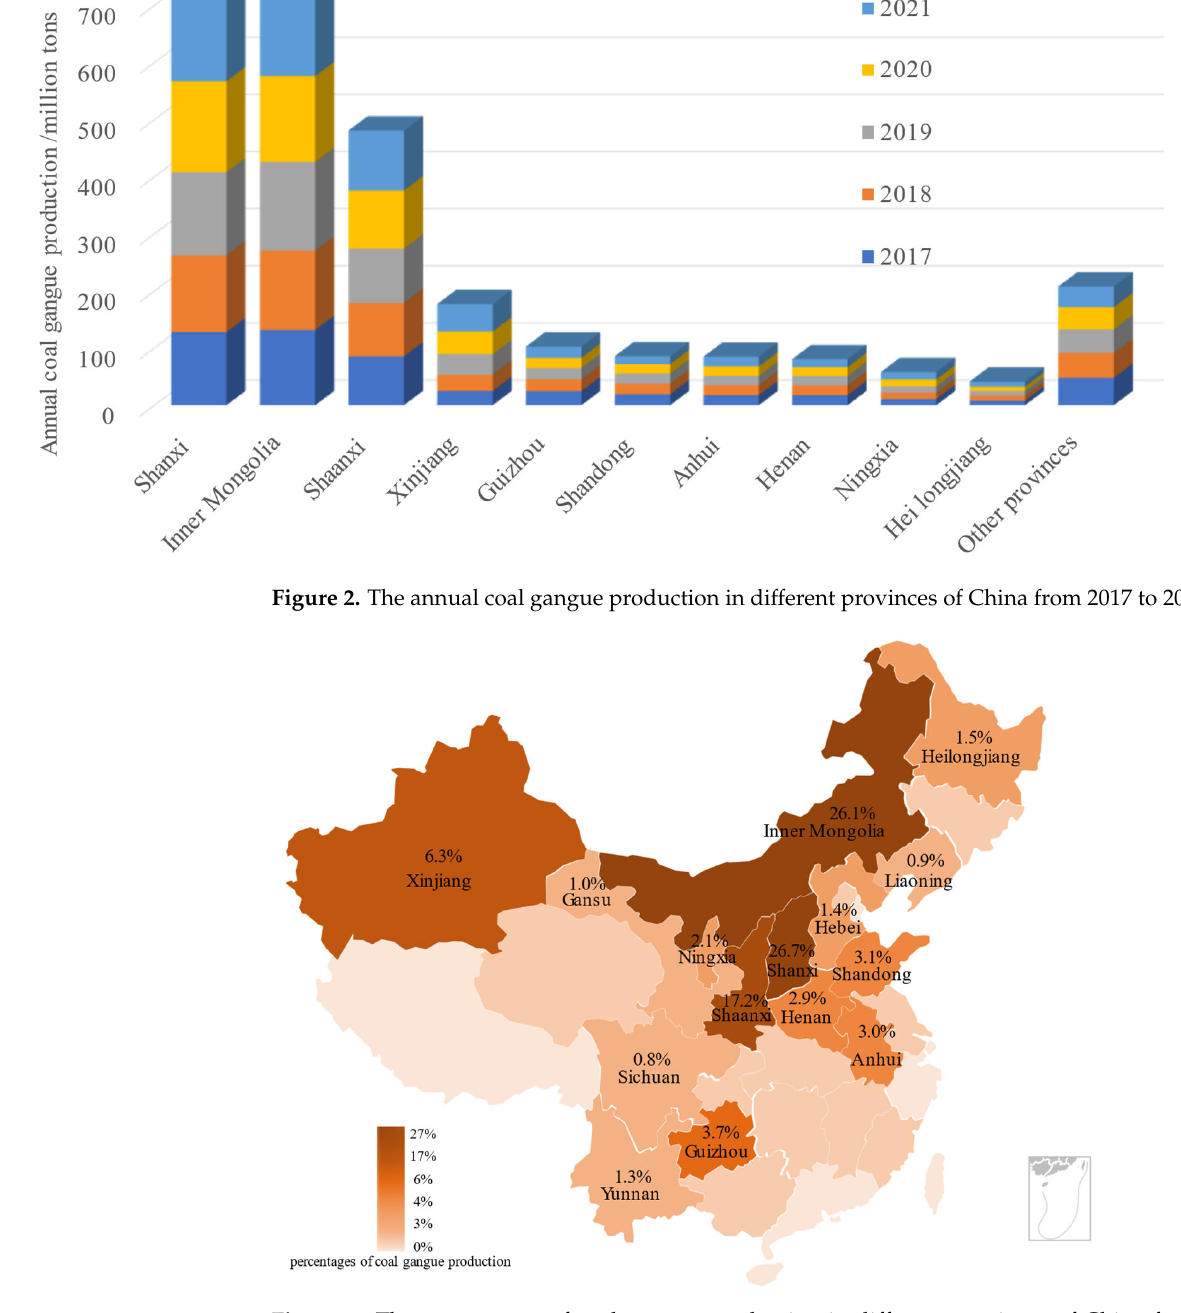
Figure 3. The percentages of coal gangue production in different provinces of China from 2017 to 2021.